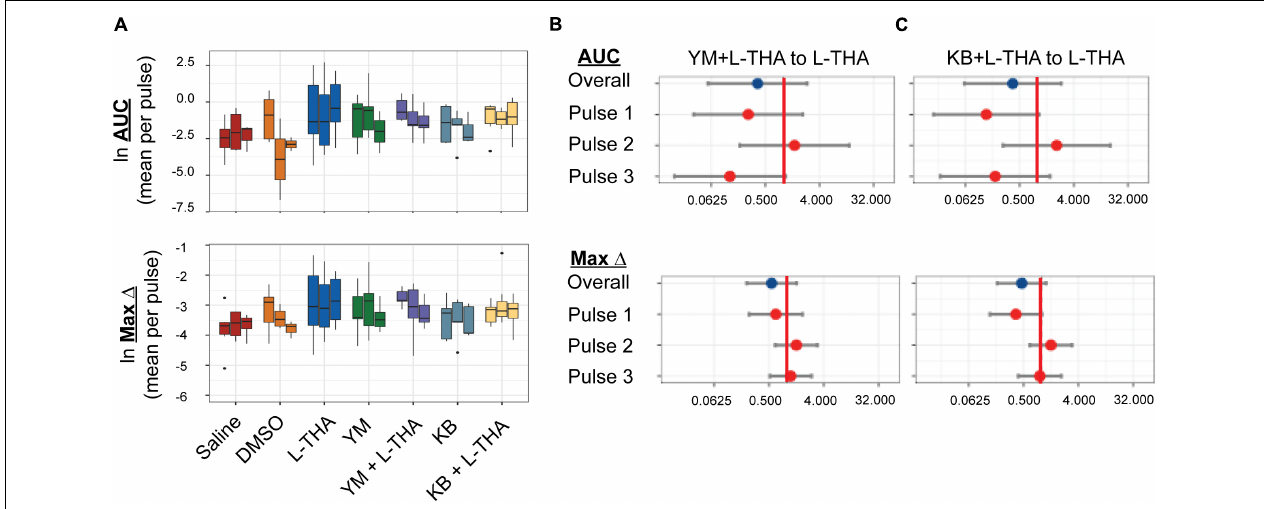
FIGURE 7 | Effects of saline, L-THA, YM-244769, KB-R7943, and YM or KB with L-THA on arteriole diameter. Saline, L-THA (100 µ M), YM-244769 (1 µ M), KB-R7943 (15 µ M), or a combination of YM or KB with L-THA were picospritzed near cortical arterioles. (A) Data are presented as boxplots. Forest plots are also included to show the mean differences expressed as ratios of the effect observed with YM with L-THA (B) or KB with L-THA (C) over that observed with L-THA. The redline is at 1 and represents no difference. The data for saline and L-THA are described in Figure 4 legend, the data for YM are from 6 animals (3 males, 3 females), the data for YM with L-THA are from 6 animals (2 males, 4 females), the data from KB are from 5 animals (1 male, 4 females) and the data for KB with L-THA are from 7 animals (5 males, 2 females).